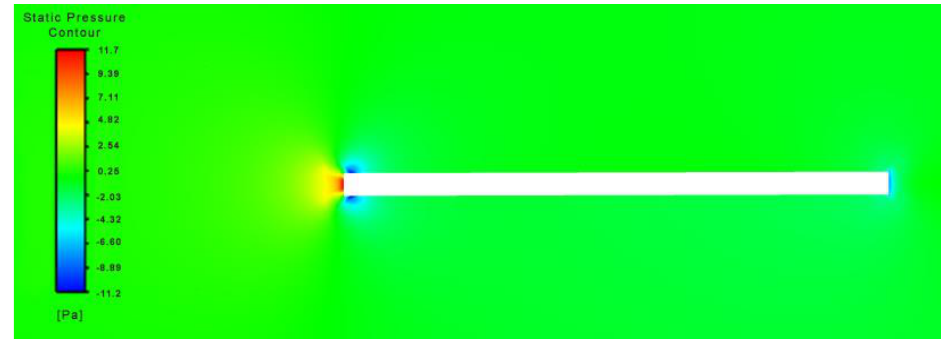
Figure 16. Static pressure distribution over flapping flat plate at t = 0.001.